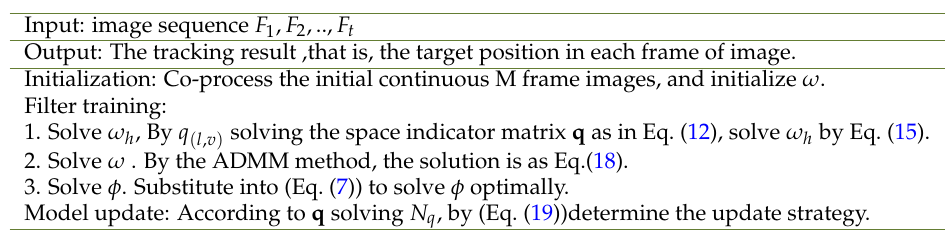
Table 1. Filter training process